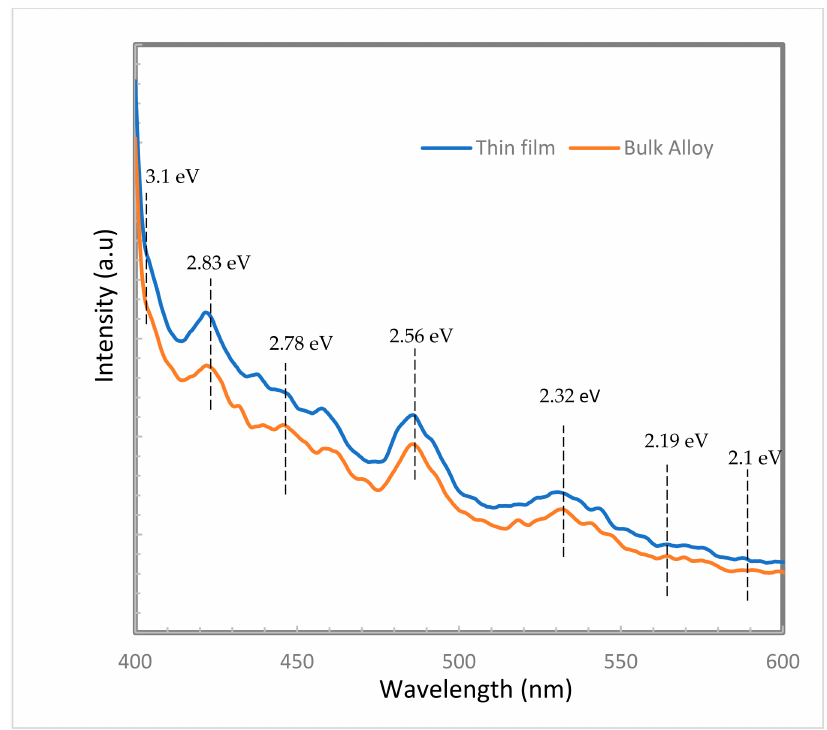
Figure 5. Bandgap of GaN bulk alloy and thin